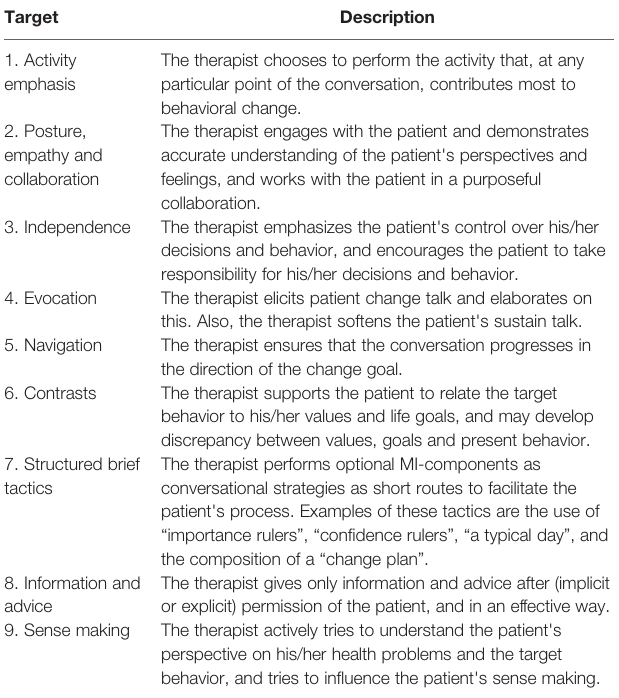
TABLE 3 | Topics of a worksheet for the qualitative analysis of the cases. Target